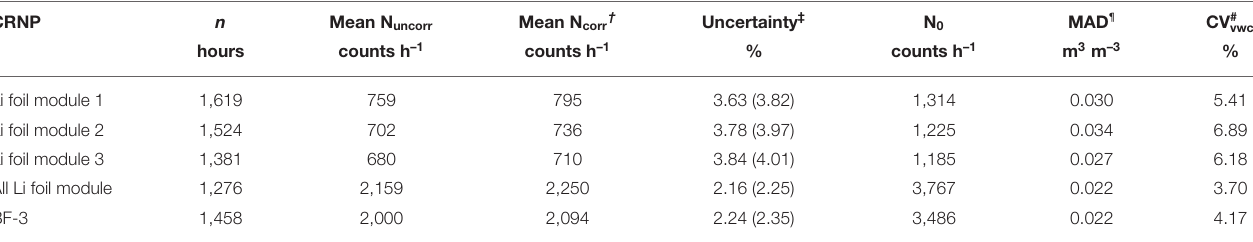
TABLE 2 | Summary of mean uncorrected (N uncorr ) and corrected (N corr ) neutron intensities, uncertainty, device-specific parameters (N 0 ), mean absolute difference (MAD), and coefficient of variation of estimated volumetric water content (CV vwc ) for the Li foil and BF-3 stationary systems. CRNP n